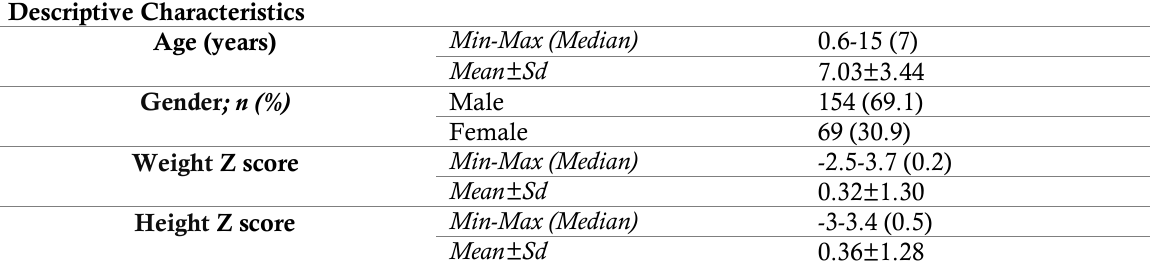
Table 1 . Distribution of Descriptive Characteristics